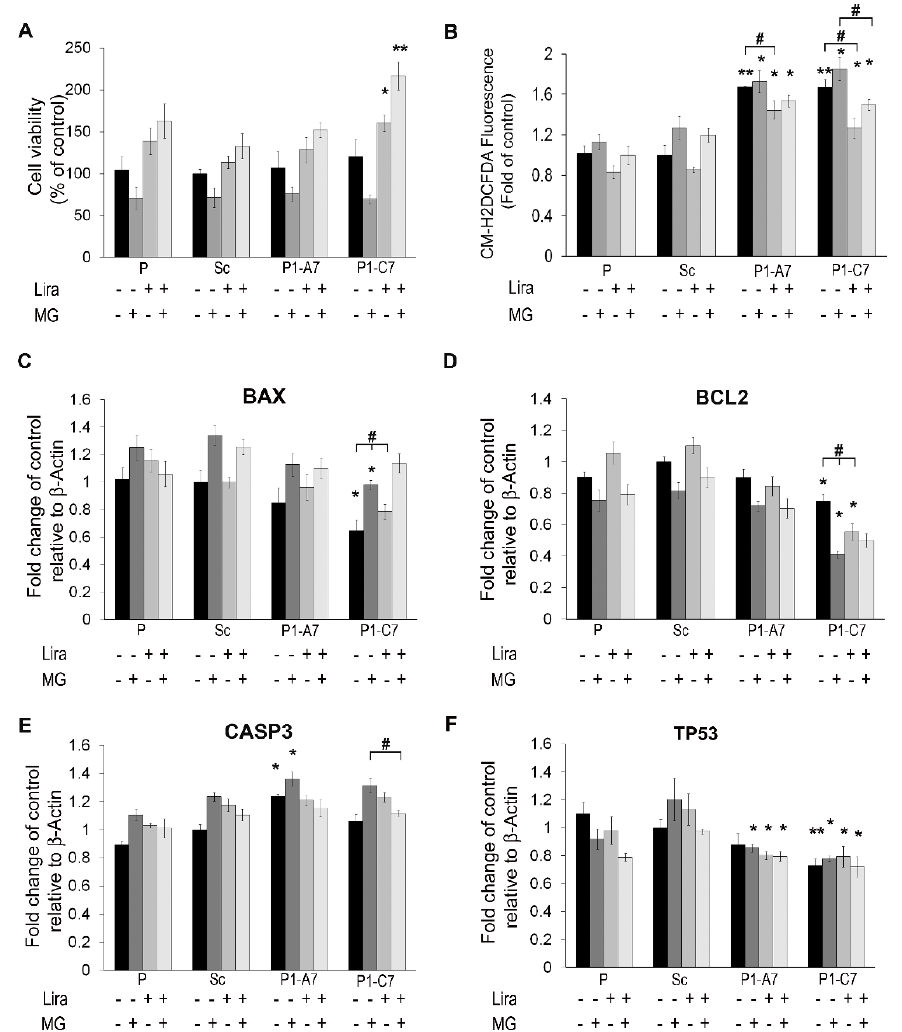
Figure 7. Lira treatment alleviated MG toxic e ff ect. ( A ) Cell viability was evaluated in cells treated with / without 100 nM Lira for 5 h and then treated with / without 600 µ M MG for 24 h. Cell viability was measured as percentage of viability in the scramble clone (Sc) by MTT assay. ( B ) ROS production was evaluated in cells treated with / without 100 nM Lira for 5 h and then treated with / without 600 µ M MG for 24 h. ROS production was measured by CM-H2DCFDA fluorescence intensity indicated as fold of that in the Sc clone. ( C – F ) Quantitative evaluation of mRNA expression level of apoptotic genes: BAX , BCL 2, CASP 3, TP 53 in cells treated with / without 100 nM Lira for 5 h and then treated with / without 600 µ M MG for 24 h. Results are expressed as mean values ± SD. * p < 0.05; ** p < 0.01 vs.